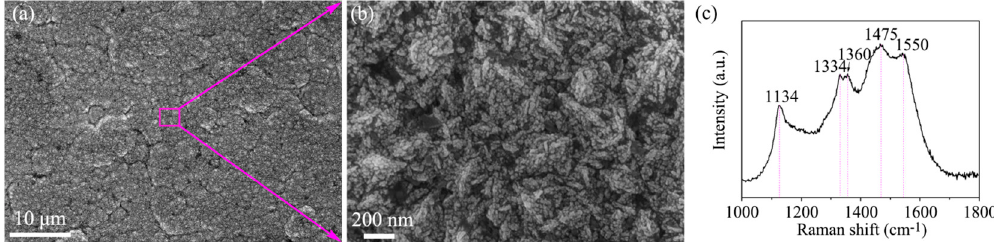
Figure 9. ( a , b ) SEM images and ( c ) Raman spectra of as-deposited diamond coatings on the HfC-SiC bi-interlayered substrates; (b) shows the partial enlargements of the overall views in (a) .